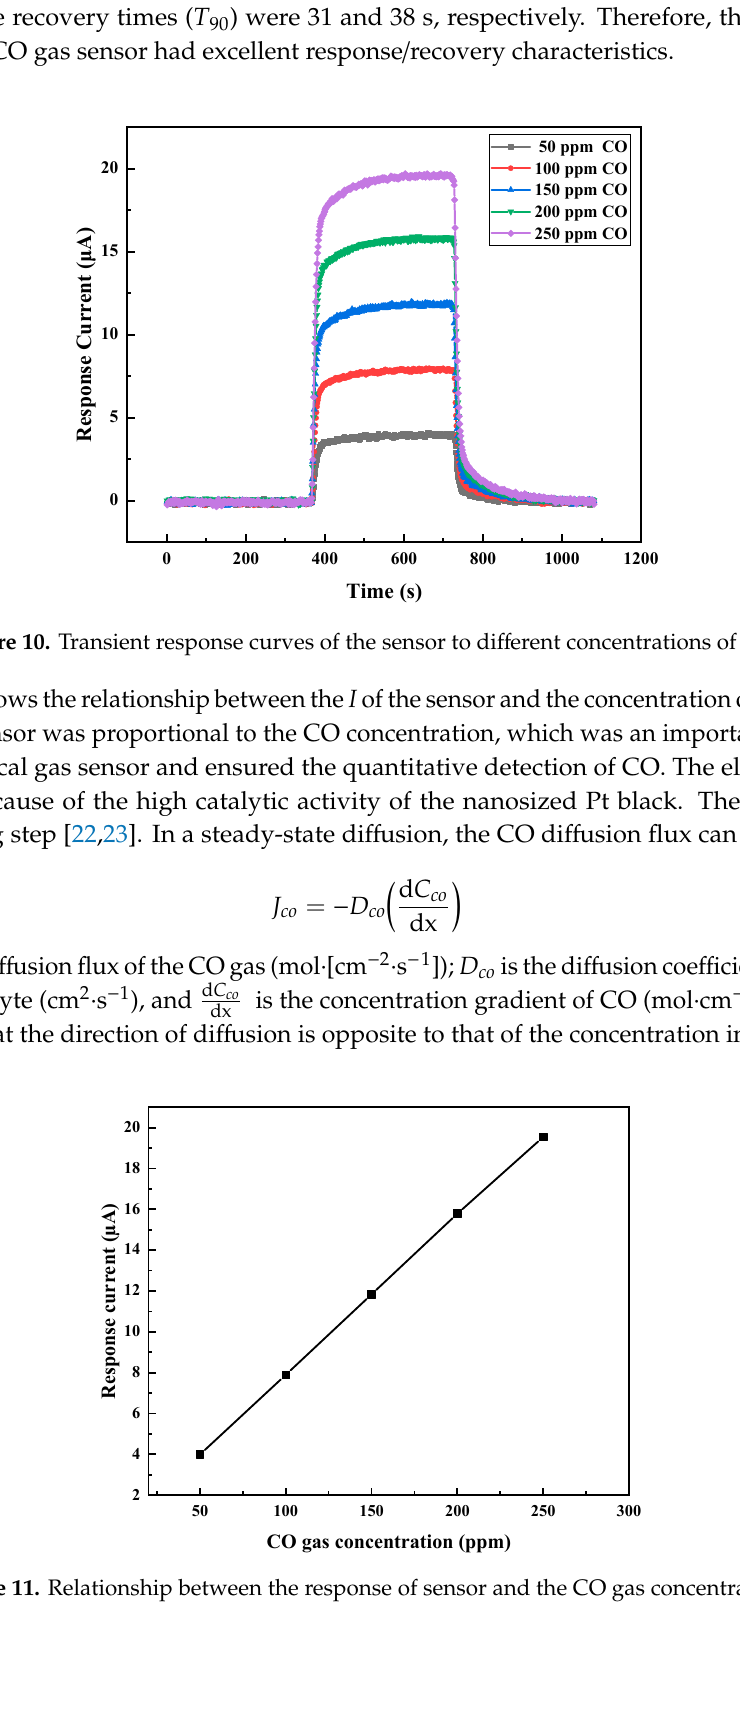
Figure 9. Transient response curves of the sensors to 200 ppm CO.